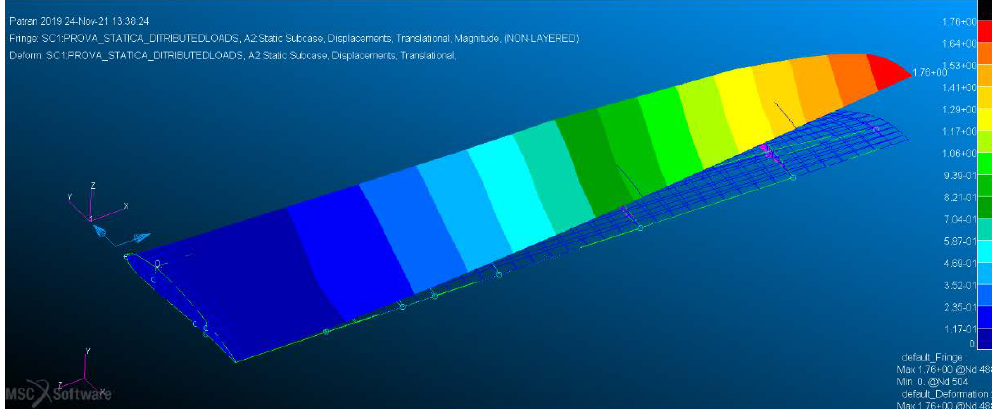
Figure 6. Half-wing deformed shape and displacements (magnitude) distribution (mm).